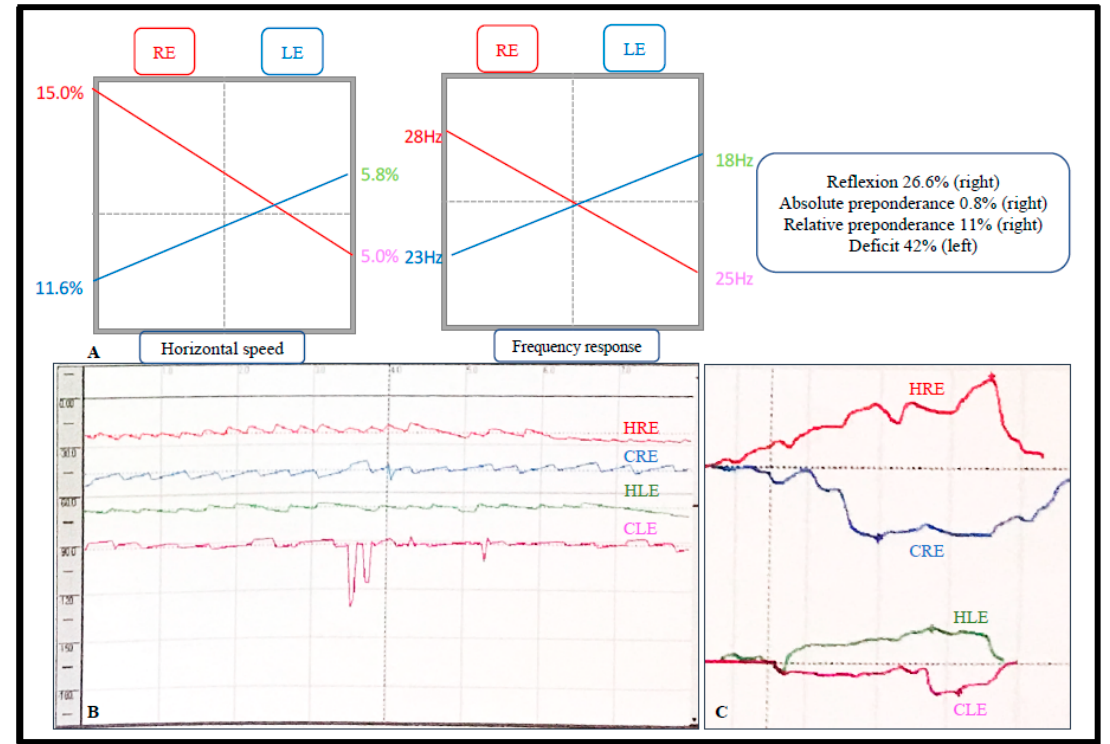
Figure 2. Results of a representative pathological caloric test (patient 6). For method, see Supplementary Figure S4. ( A ) Graph summarizing the results of the caloric test, showing a left vestibule deficit of 42%. RE, right ear; LE, left ear. ( B ) Graph showing the nystagmus after stimulating (hot-water irrigation) or inhibiting (cold-water irrigation) each vestibule. SN, spontaneous nystagmus (dark line: spontaneous eye movement (no nystagmus)); HRE, hot water, right ear (red line: nystagmus after right-ear hot-water irrigation); CRE, cold water, right ear (blue line: nystagmus after right-ear cold-water irrigation); HLE, hot water, left ear (green line: nystagmus after left-ear hot-water irrigation); CLE, cold water, left ear (pink line: nystagmus after left-ear cold-water irrigation). ( C ) Comparison of nystagmus after irrigating the right ear (red and blue curves) and the left ear (green and pink curves). The intensity is weaker after irrigation of the left ear than of the right